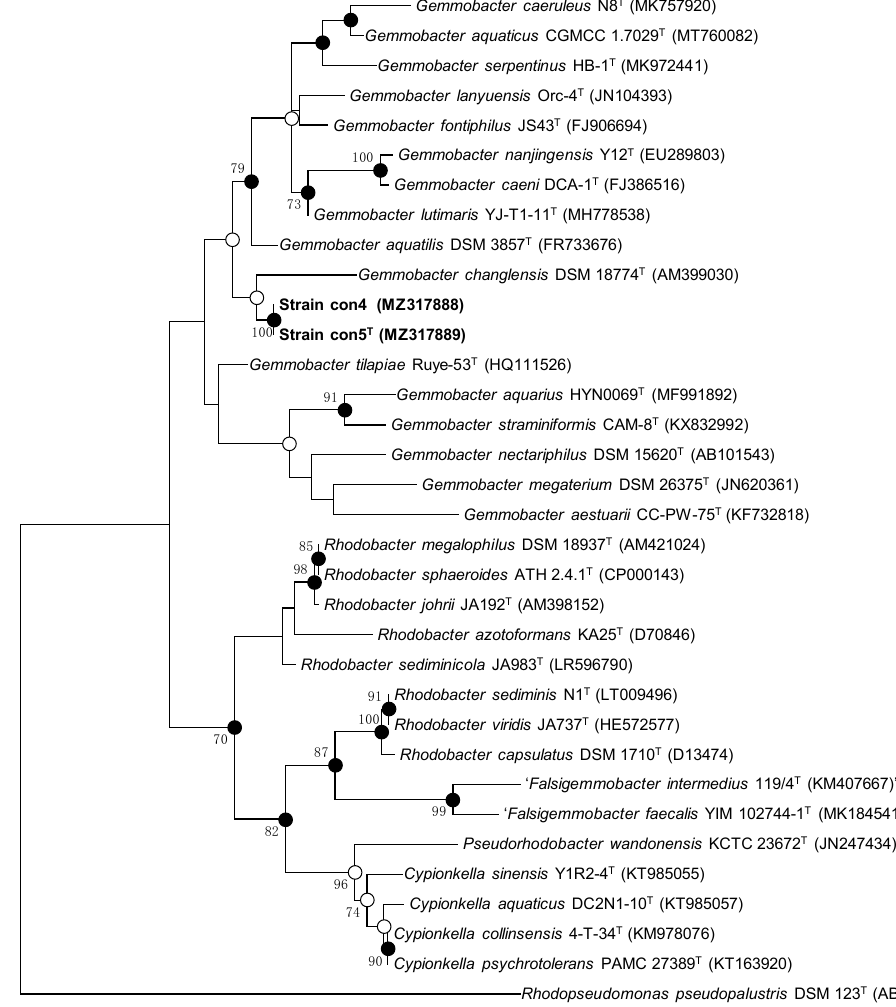
Figure 1. Maximum likelihood phylogenetic tree based on 16S rRNA gene sequences showing the position of strains con5 T and con4 within Gemmobacter . Sequences of related species in the Rhodobacteraceae family are shown. The numbers at the branch-nodes represent the percentage of 1000 bootstrap replicates; only values above 70% are depicted in the tree. Filled circles indicate the corresponding nodes recovered by ML, MP, and NJ phylogenetic trees. Open circles indicate the corresponding nodes were also recovered with either the ML or MP algorithm. The analysis involved a total of 1308 aligned nucleotide positions in the final dataset. Table 2. General features and relationship of the genomes of strains con5 T and con4 with the closely related species of the genus Gemmobacter .